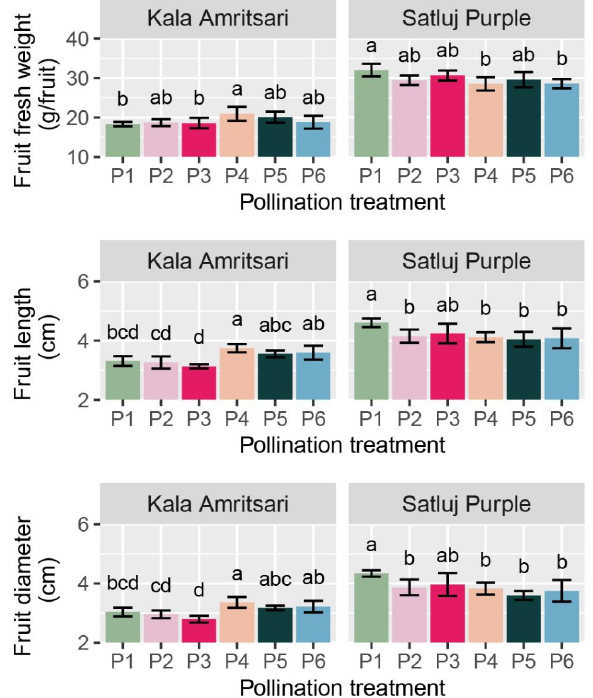
Figure 6. Fresh weight, length, and diameter of fruits of ‘Satluj Purple’ and ‘Kala Amritsari’ plum trees exposed to six pollination treatments: self-pollination (P1), open-pollination with the two cultivars located in adjacent rows (P2), open-pollination with the two cultivars located in distant rows (P3), manual cross-pollination (P4), supplementary pollination (P5) and floral bouquet (P6). For each parameter and separately for each cultivar, different letters indicate significant differences between pollination treatments according to the Tukey’s HSD test.